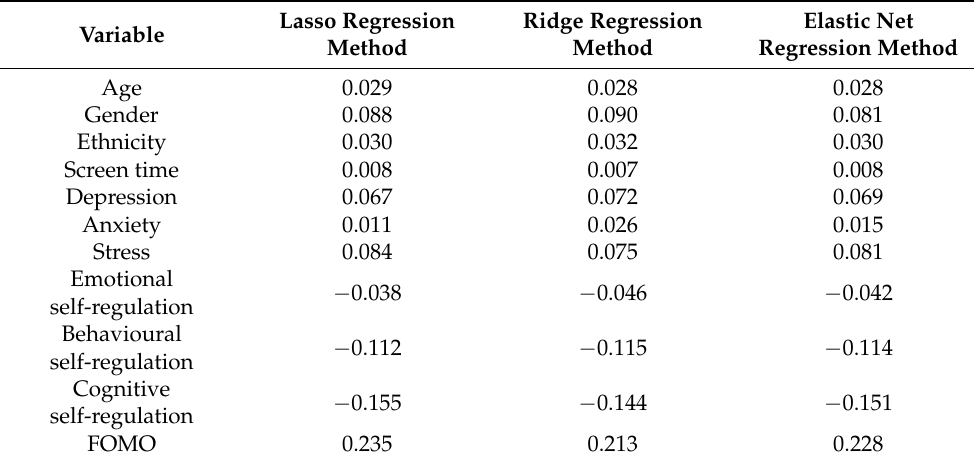
Table 4. Variable Importance Coefficients for the Lasso, Ridge and Elastic Net Machine Learning Algorithms in Predicting Problematic Smartphone